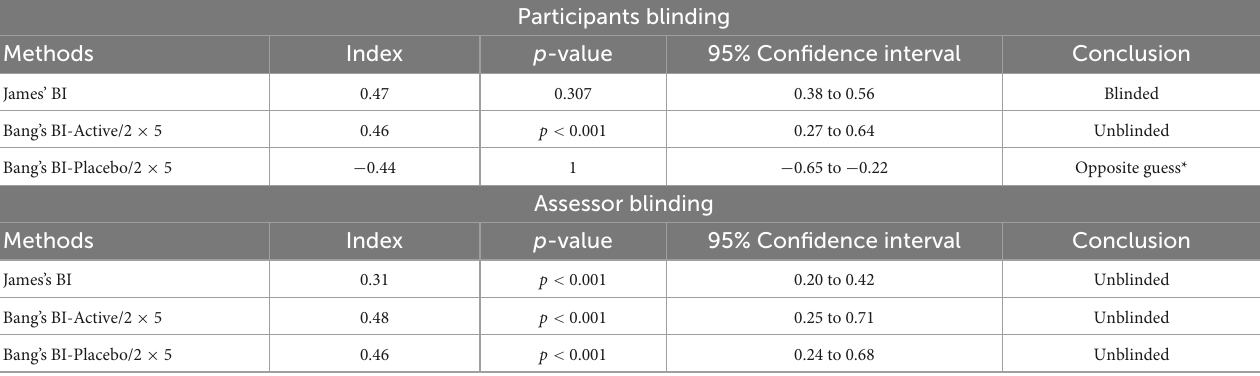
TABLE 5 Statistical analysis of blinding